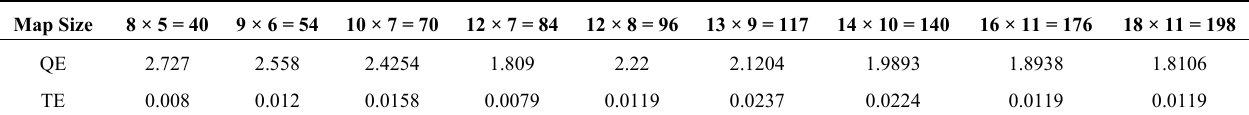
Table 3. Map quality measures at different map sizes of the trained SOM.